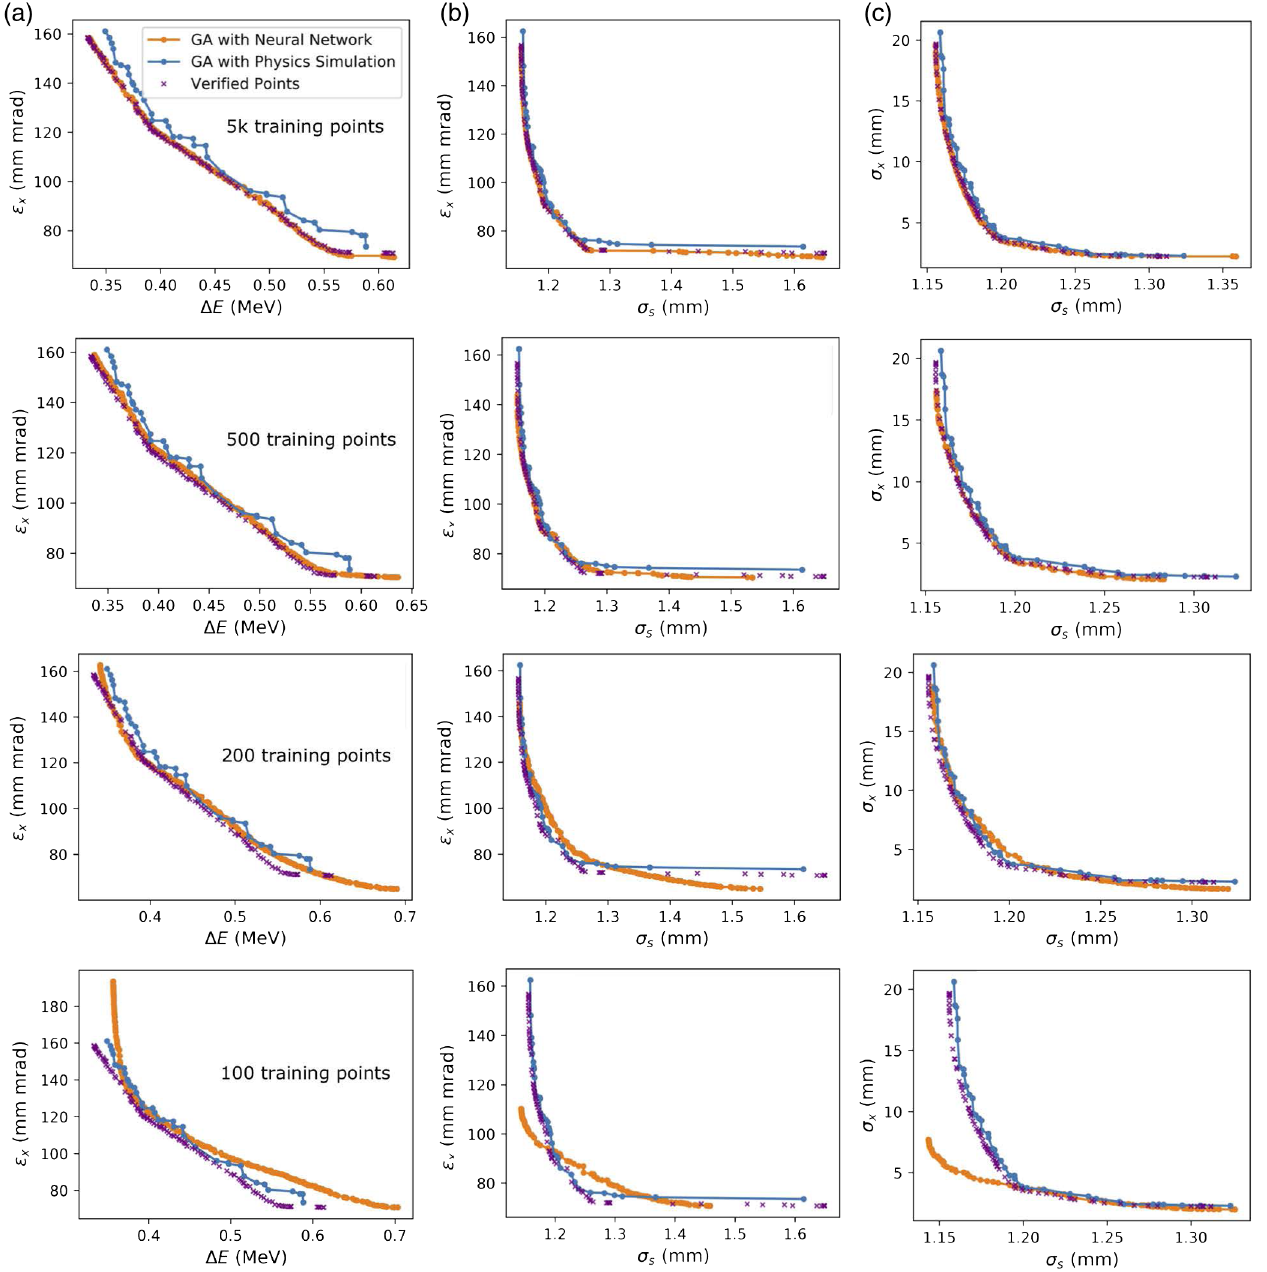
FIG. 6. Impact of training sample size on the quality of the estimated Pareto front solutions. We show a comparison between estimated Pareto fronts obtained from the NN for three sets parameters in the 40 nC case: Δ E vs ε 500, 200, and 100 training points are shown from top to bottom. 500 randomly sampled training points are sufficient in this case for obtaining an accurate estimated Pareto front with the NN model. For 200 training points, the estimated Pareto front is quite a bit less accurate but still could provide an initial population for subsequent fine-tuning with a GA run on the physics